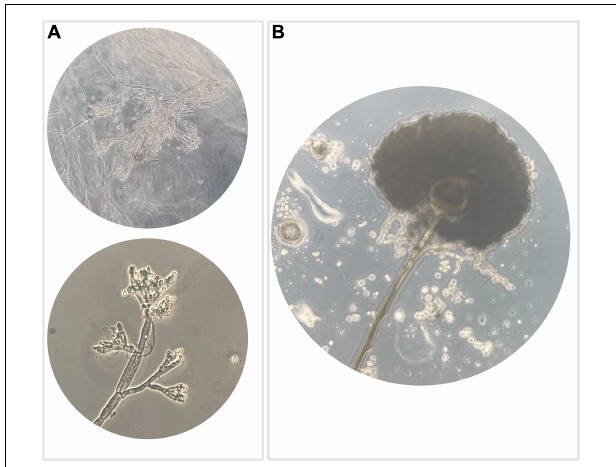
FIGURE 3 | Optical microscope observation highlighting: (A) typical structure of agamic reproduction of the genus Penicillium , which is shaped like a “brush” with a basal conidiophore branch from which the metulae differentiate, inserted rod-like structures that in turn branch out with phialides that generate a chain of conidia usually roundish; (B) anamorphic reproductive structures of the genus Aspergillus , which include a conidiophore branch that at the apex differentiates a spheroidal vesicle that generates metulae that in turn give rise to phialides responsible to produce conidia